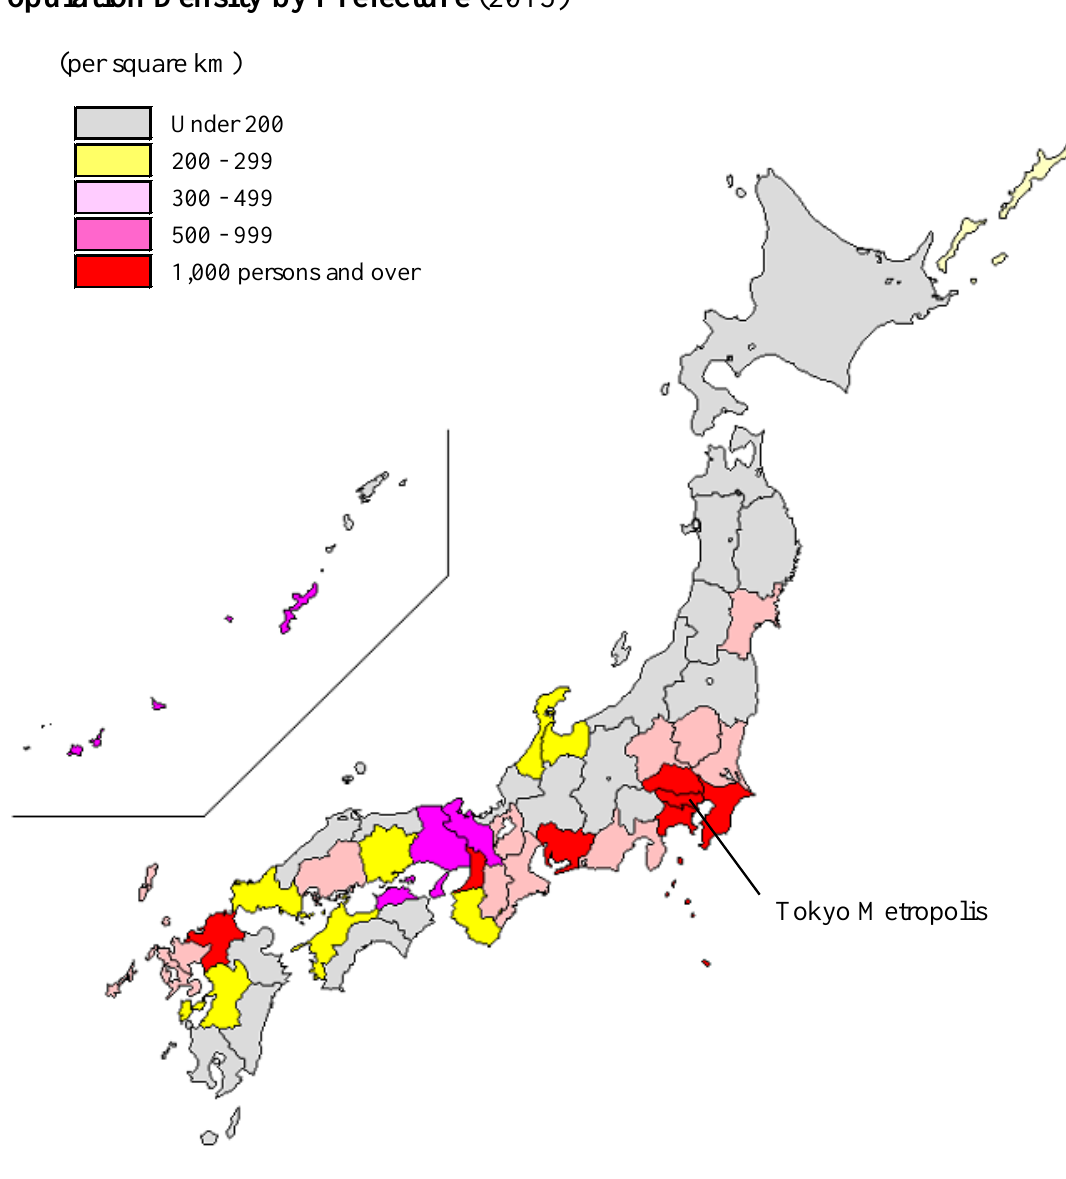
Population Density by Prefecture